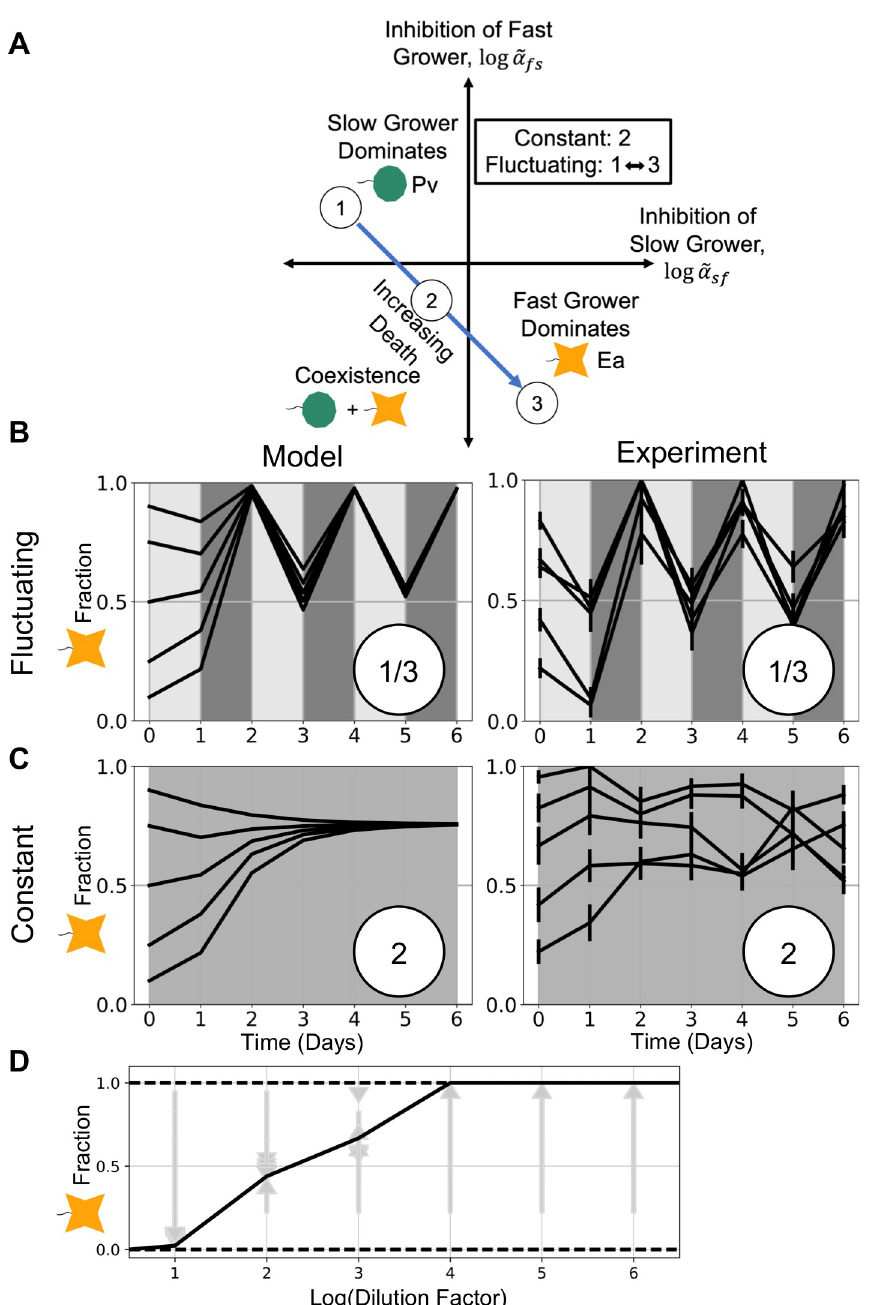
Fig 3. Coexistence occurs in both fluctuating and average environments, confirming model prediction. A : As in Fig 2, the LV model phase space shows qualitative outcomes divided by the zero-points of the logarithm of the reparametrized competition coefficients. Here we have illustrated the trajectory of a pair that passes through the coexistence region as the death rate increases. B-C : When we cocultured slow-growing Pv with another fast grower, Ea , we observed coexistence in an environment that fluctuated between dilution factors in which either species dominated (upper right). At a dilution factor equal to the mean of fluctuations, we also observed coexistence (lower right), confirming the model’s prediction about a time-averaged environment for both types of trajectories across the phase space. Once again, simulations of daily dilutions showed good agreement between the model and experimental results (left). D : A diagram of outcomes at all constant dilution factors shows that fast-growing Ea is favored as dilution increases. Arrows represent time trajectories from initial to final fractions; solid lines represent stable equilibria, and dotted lines represent unstable fractions. We used this diagram to estimate the competition coefficients used